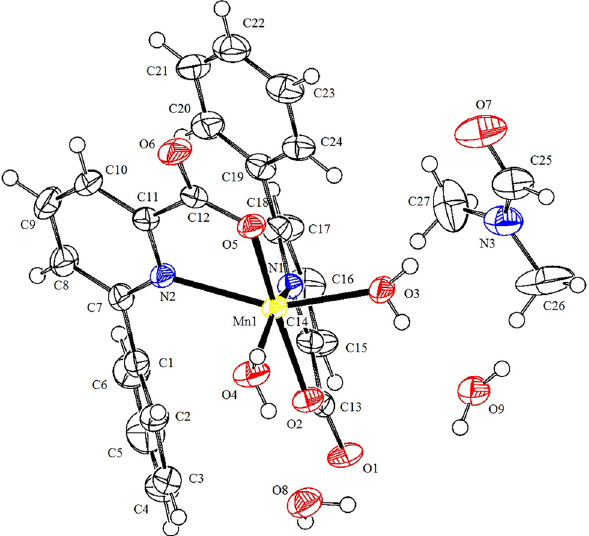
Table 1 contains crystallographic data and Table 2 contains the list of the atoms including atomic coordinates and displacement